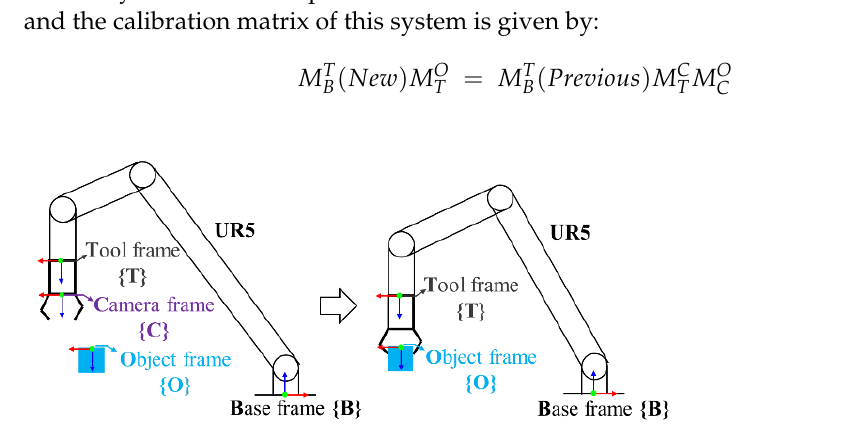
Figure 22. Shape profile and centroid location identified by the Douglas – Peucker algorithm ( left ). Illustration of two-finger ( right-top ) and three-finger ( right-bottom ) modes of the gripper for the corresponding object shapes.